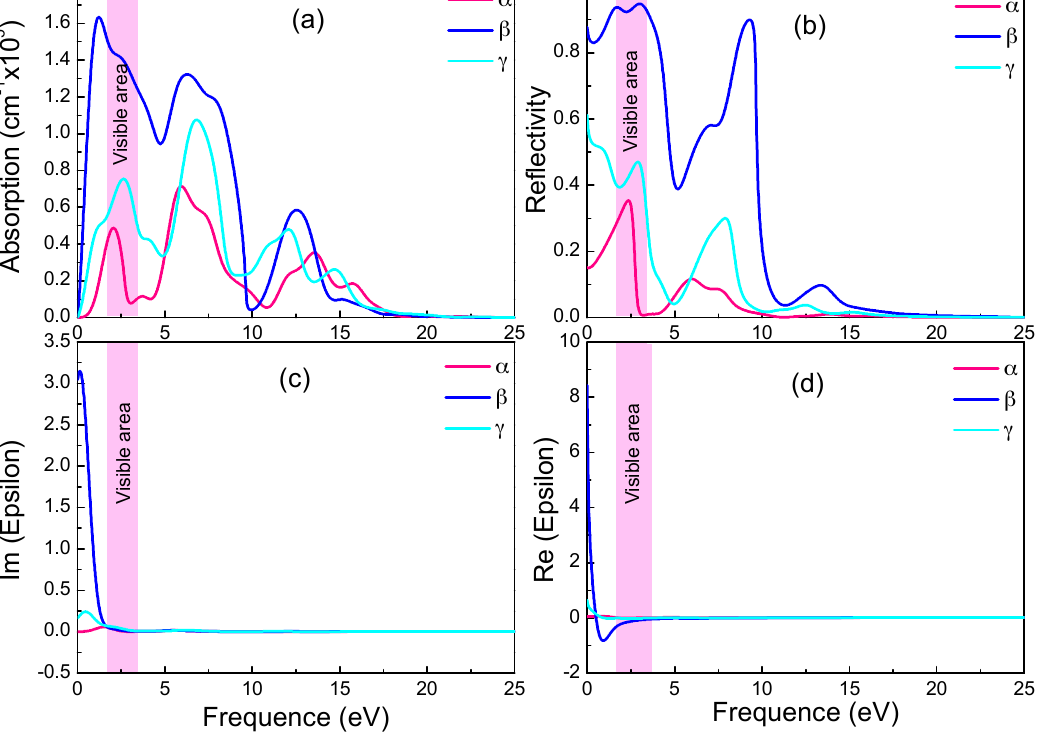
Figure 5. Absorption spectra ( a ), reflectivity ( b ), imaginary ( c ) and real ( d ) part of the dielectric constants of the three graphynes.